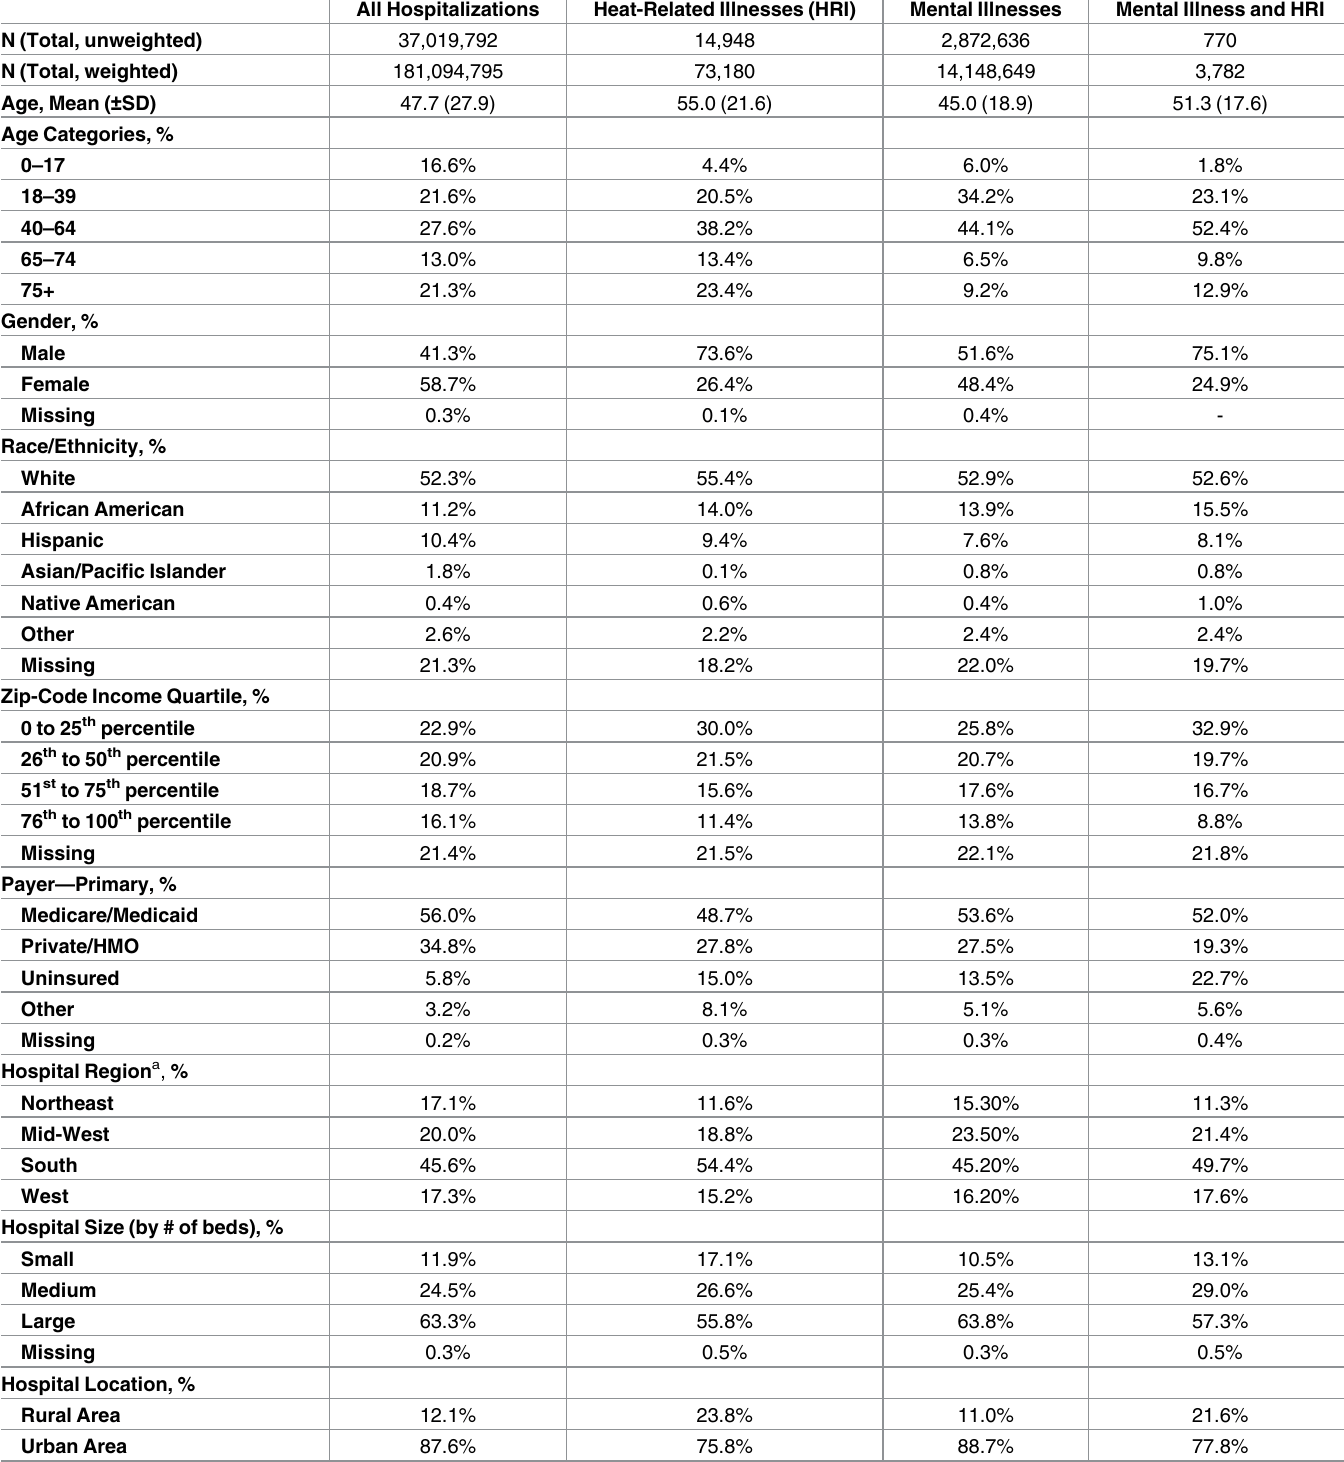
Table 1. Patient and hospital characteristics for hospitalizations of heat-related illness and mental illness/behavioral disorders *